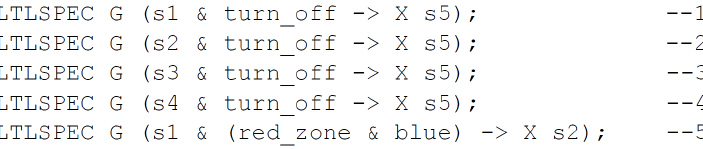
Figure 8. Sample requirements for formal verification of the case study.